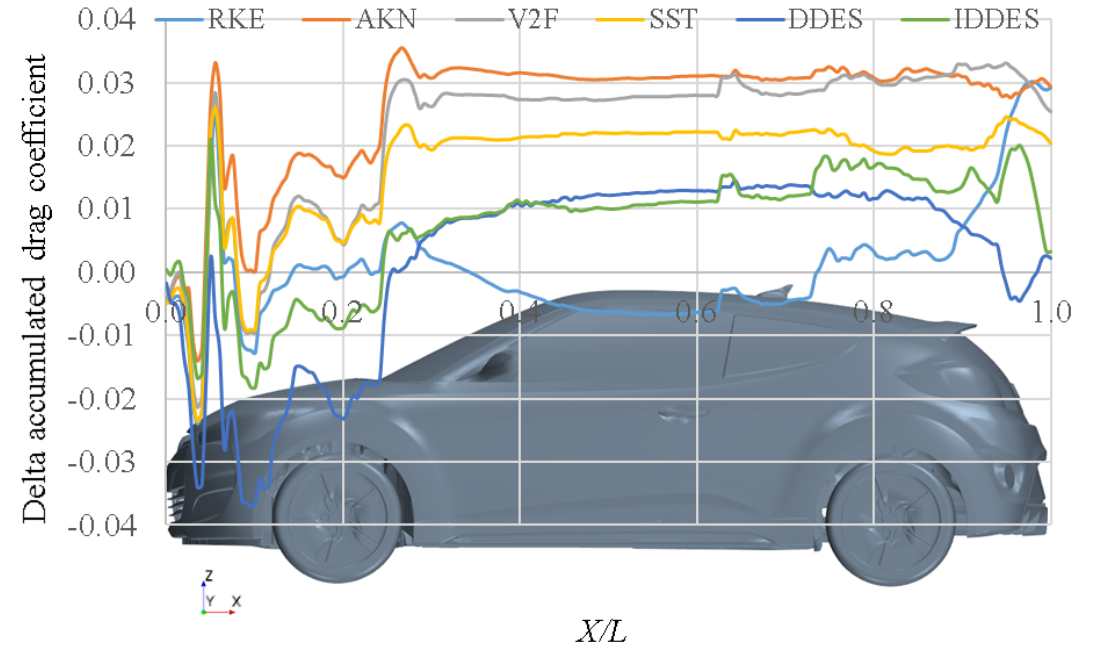
Figure 11. Delta accumulated drag coefficient between Case 1 and 2 vehicle configurations along the streamwise direction obtained from all turbulence models ( L represents the vehicle total